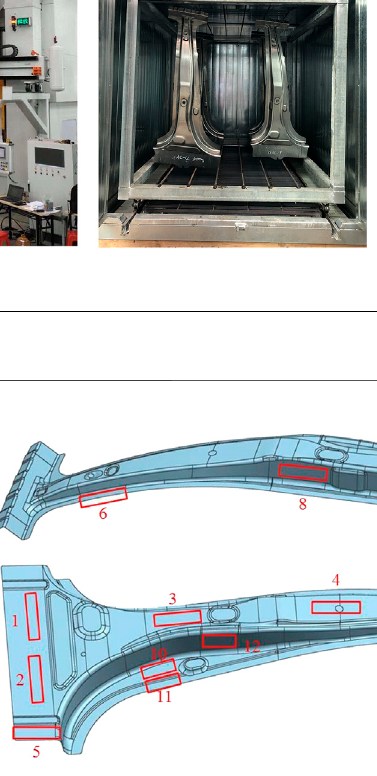
FIGURE 3 | The locations of the tension test samples in the formed parts.